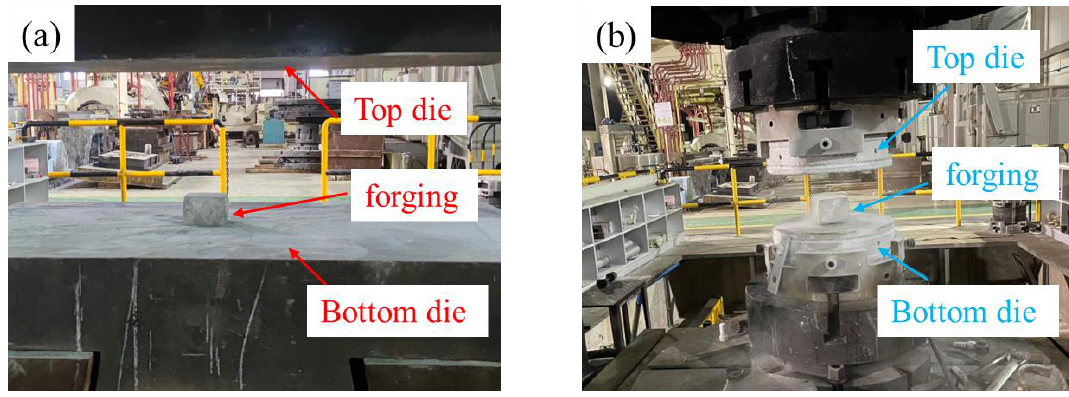
Figure 2. Multiaxial forging deformation setups: ( a ) HTD and MTD; ( b ) CTD. The microstructural evolution was observed through scanning electron microscopy (SEM, Model; TESCAN MIRA4 LMH, Brno, Czech Republic), electron backscatter diffrac- tion (EBSD, Model; OXFORD X-Max, Abingdon, UK), X-ray diffraction (XRD, Model; X’Pert PRO, Almelo, Netherlands), and transmission electron microscopy (TEM, Model; Talos F200X, Hillsboro, OR, USA). The specimens for microstructure observation were taken from the center region of the L–H plane, and the specimens for SEM observation were mechanically ground with #180, #1000, and #2000 sandpaper. For TEM observation, the thickness of the samples was reduced to 60–80 µ m with the aid of double-jet polishing.